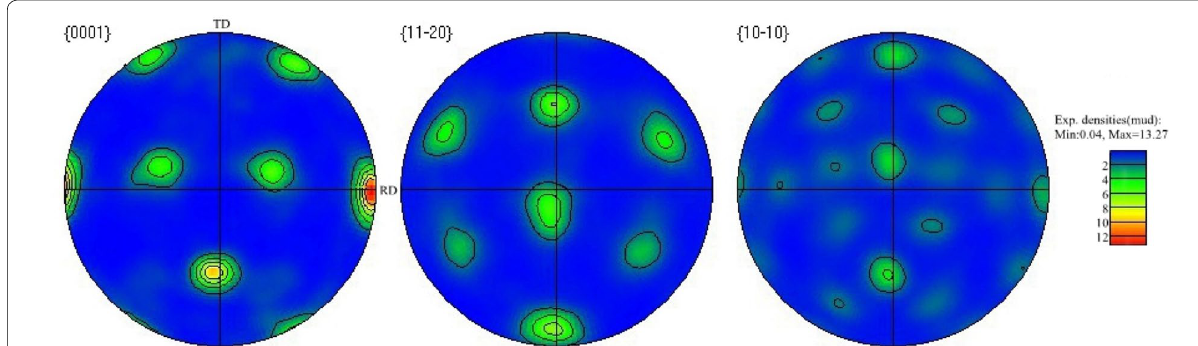
Figure 8 Pole figures of weld zone in RD-TD plan